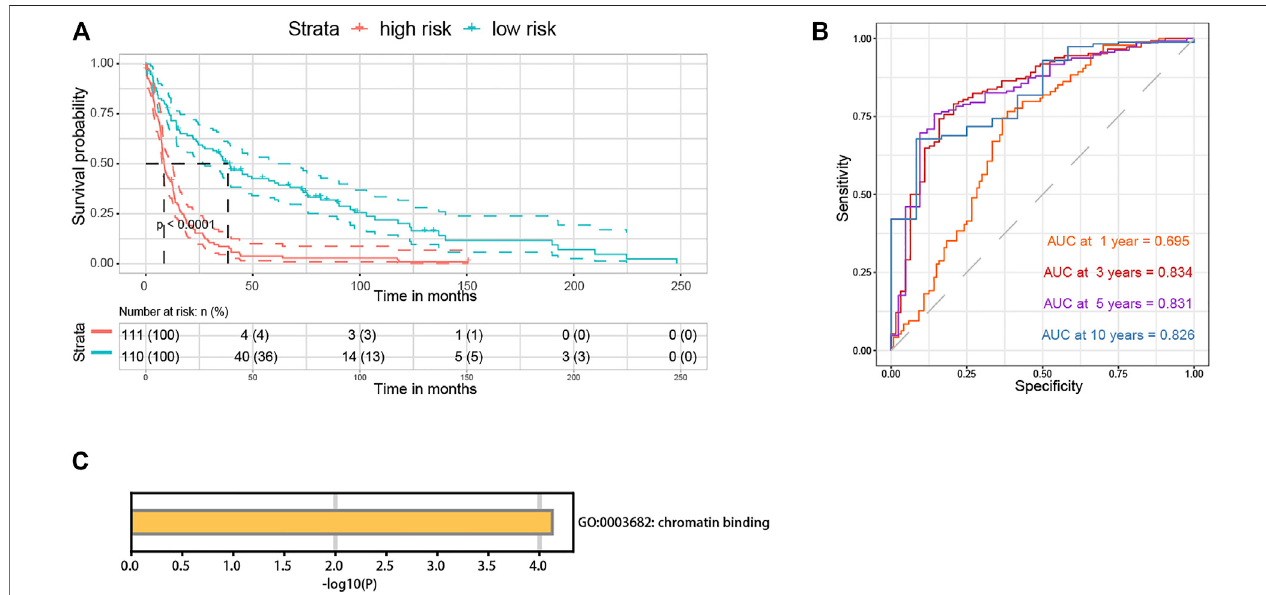
FIGURE 11 | HDAC1 -related gene signature external validation and enrichment analysis. (A) Survival curve for survival possibility test between high- and low-risk group according tothe signature risk score in the GEO cohort. (B) Time-dependent ROC curve for the separability test of the HDAC1 -related signature at 1-, 3-, 5-, and 10-years time points (OS) using the GEO validation cohort. (C) Functional enrichment analysis of the HDAC1 -related signature.